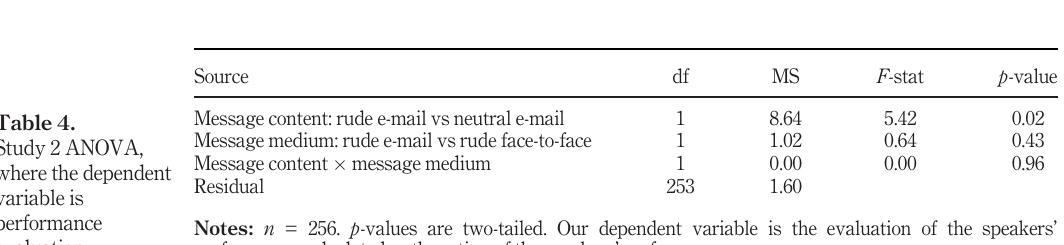
Table 4. Study 2 ANOVA, where the dependent variable is performance evaluation